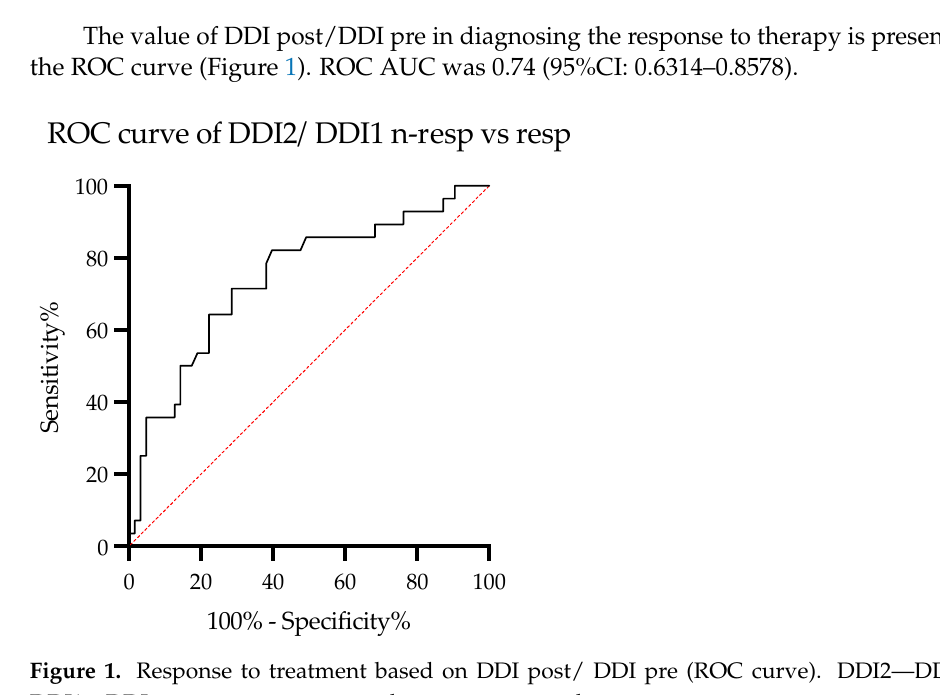
Figure 1. Response to treatment based on DDI post/ DDI pre (ROC curve). DDI2—DDI post,